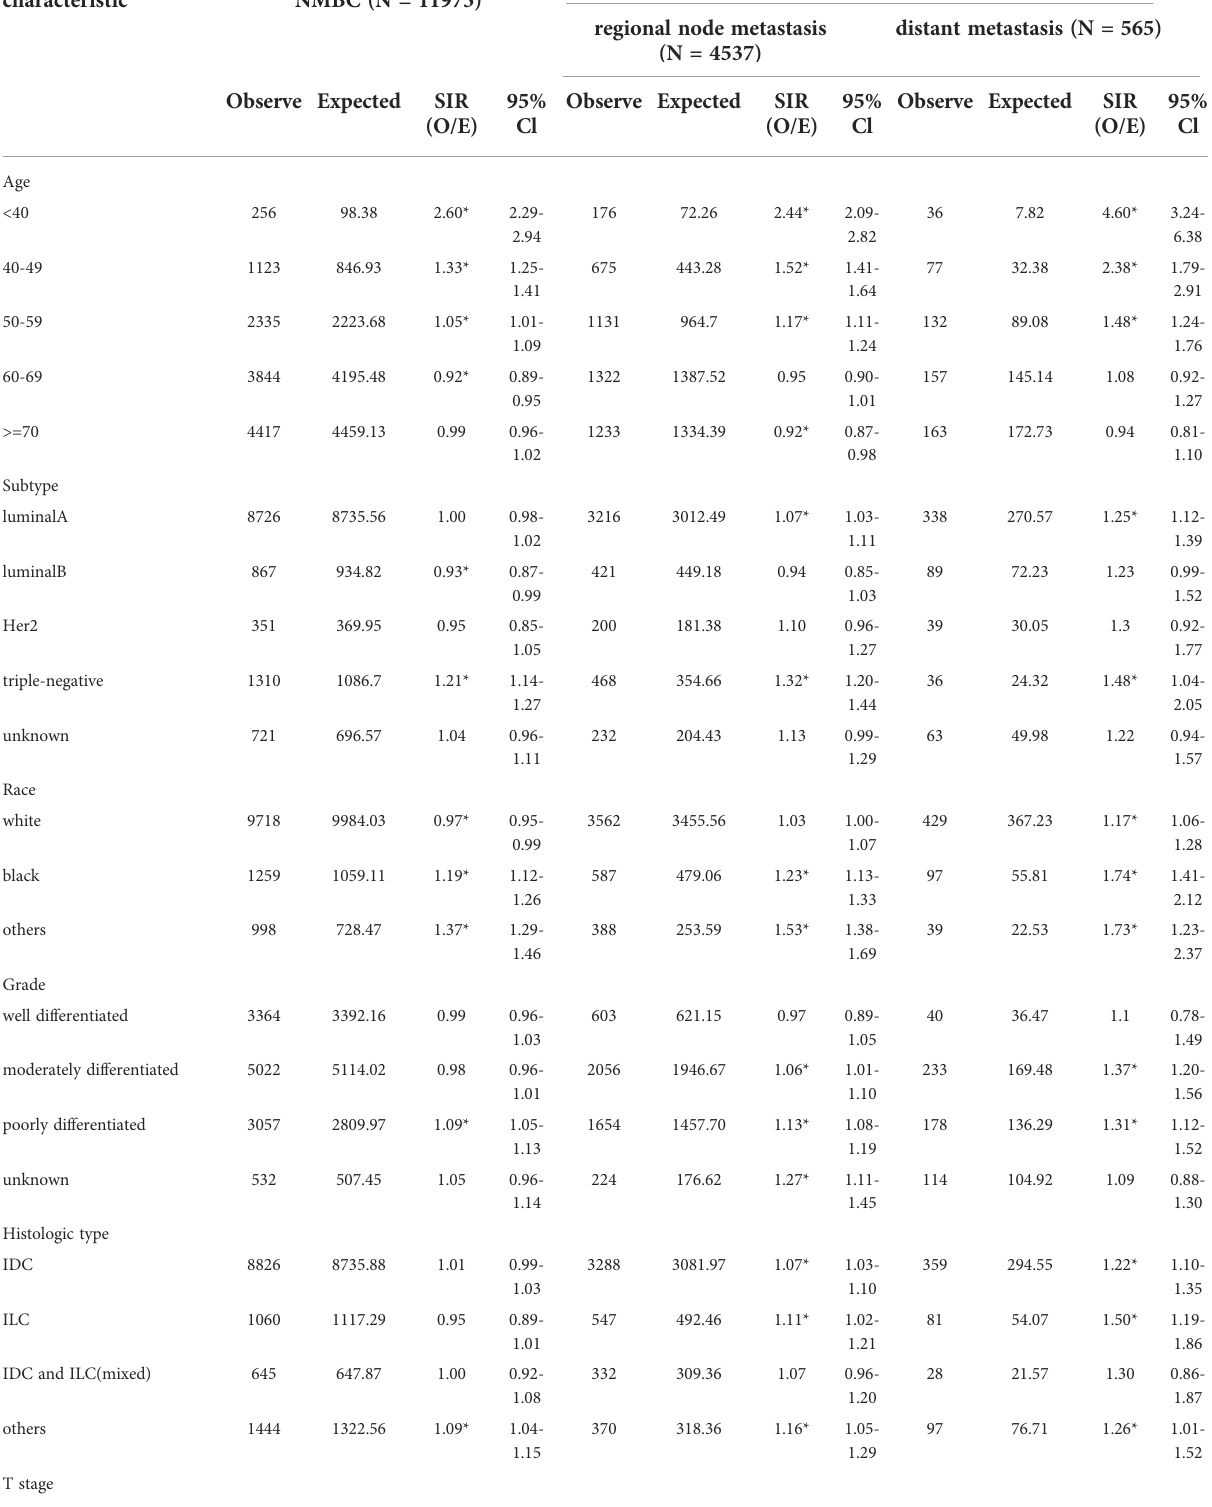
TABLE 1 Standardized incidence ratios of SPCs in BC patients by characteristic. characteristic NMBC (N = 11975)